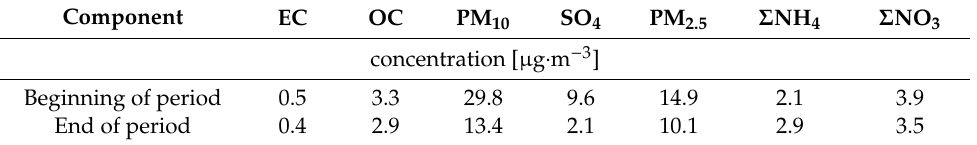
Table 3. Changes in annual aerosol concentrations at the beginning and the end of the evaluated